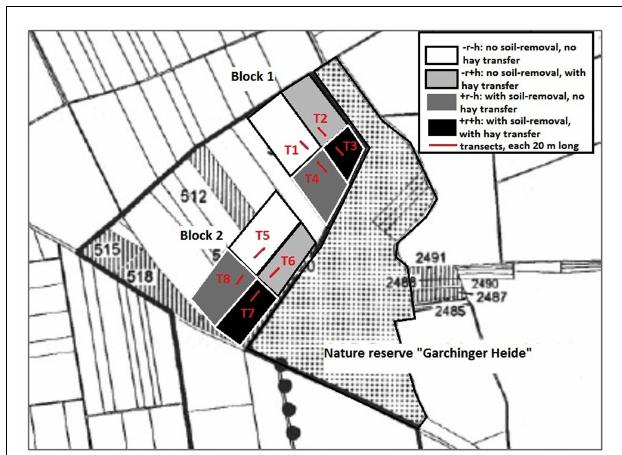
FIGURE 1 |The Garchinger Heide restoration site near Munich showing the experimental design with the four restoration treatments repeated over two blocks, and the eight transects used for sampling plant material. Transects (each 20m long) were positioned within the treatment fields (size approximately 70m × 150m):T1–T4 are in Block 1, transects T5–T8 are in block two.The restoration treatments ranging from topsoil removal and hay transfer ( + r + h ) to no action ( − r − h ) are shown in different colors on the